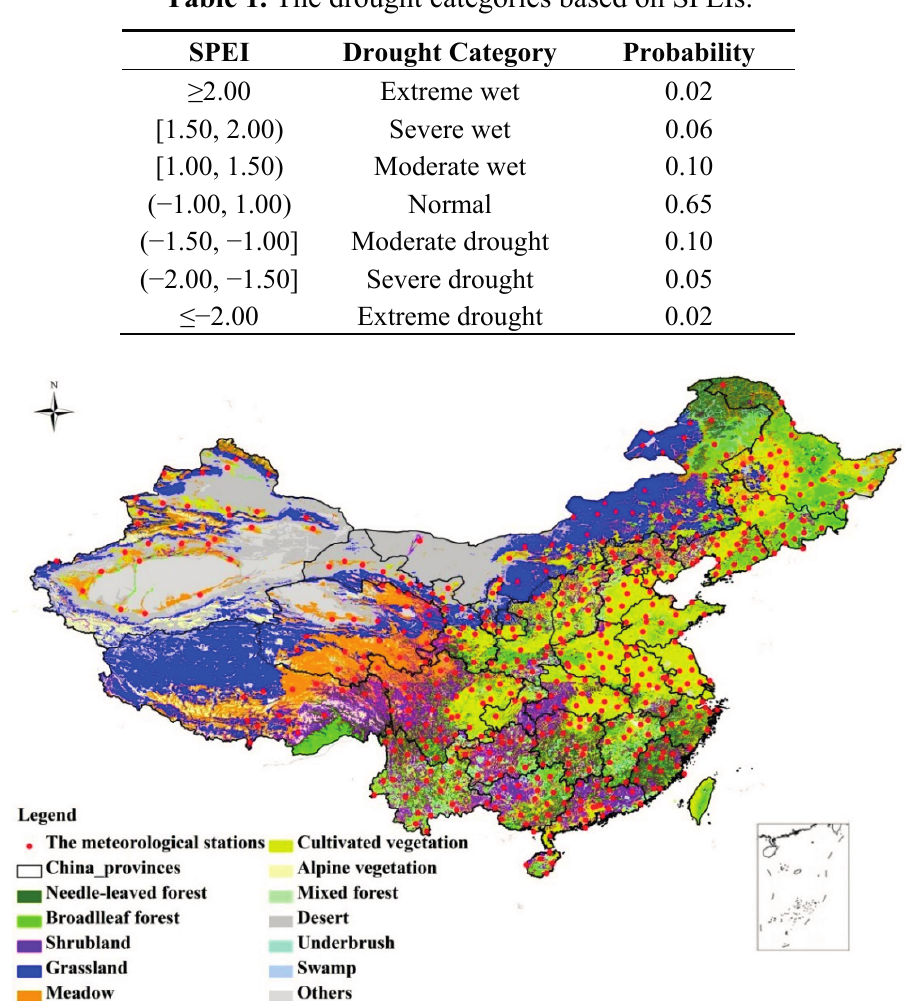
Table 1. The drought categories based on SPEIs.